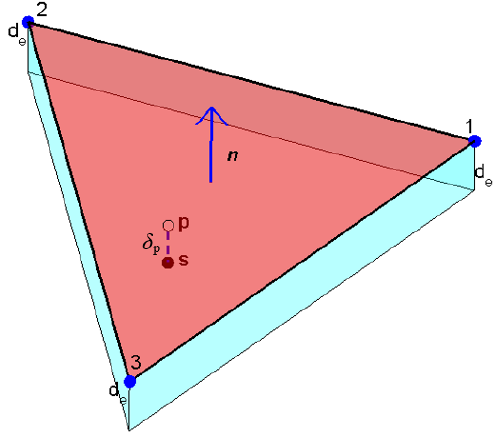
Figure 3. Schematic diagram of crossover test.